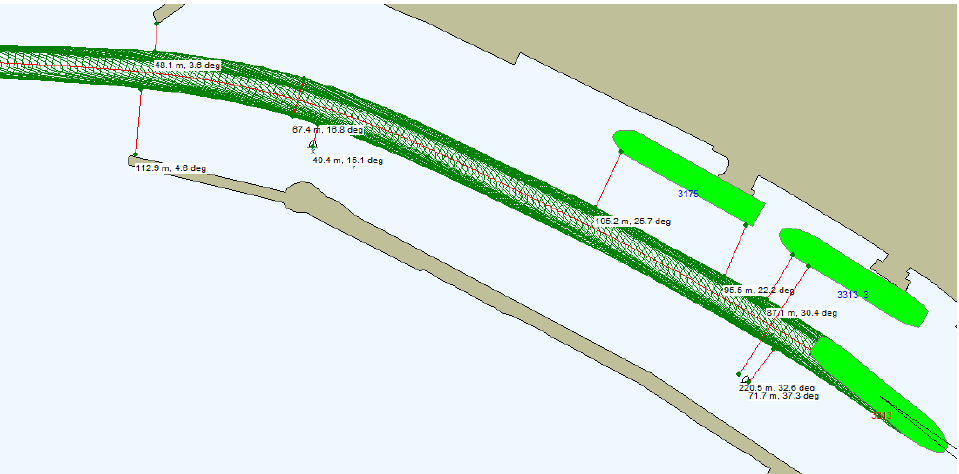
Figure 13. A SUEZMAX tanker’s sailing trajectory while crossing channel bend at the entrance of Klaipeda port (own elaboration based on [73]).